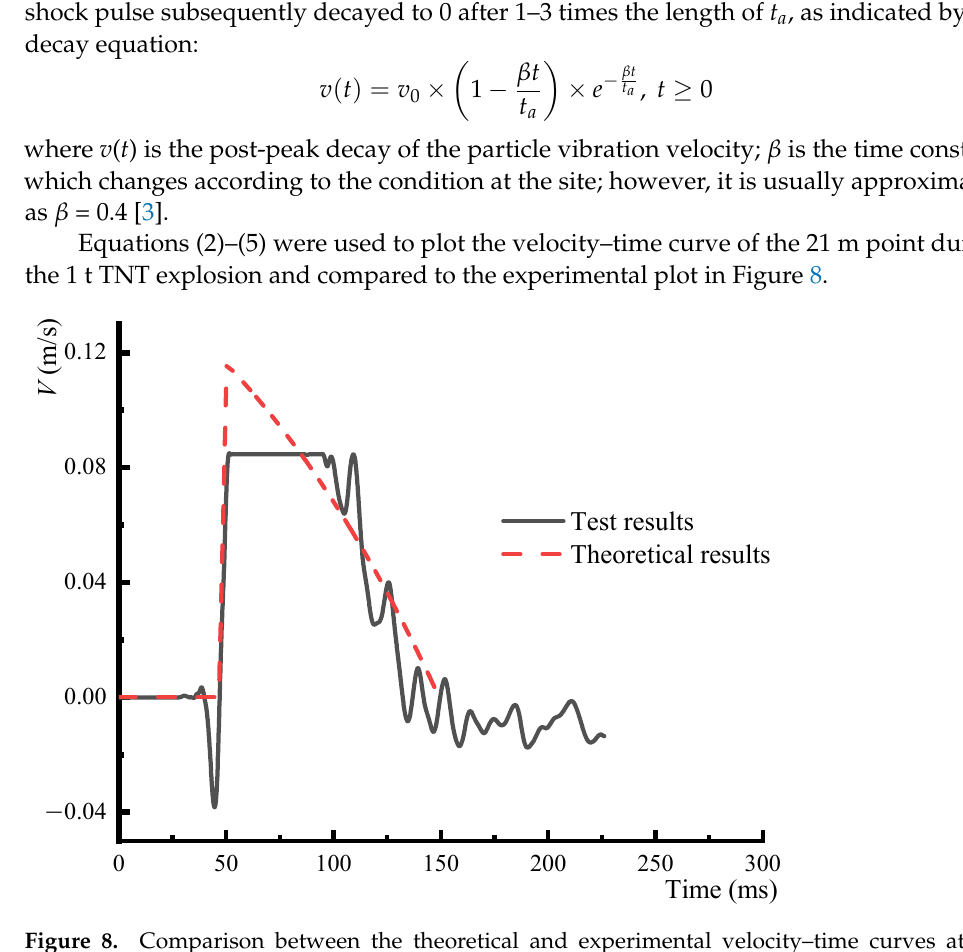
Figure 8. Comparison between the theoretical and experimental velocity–time curves at the 21 m point.